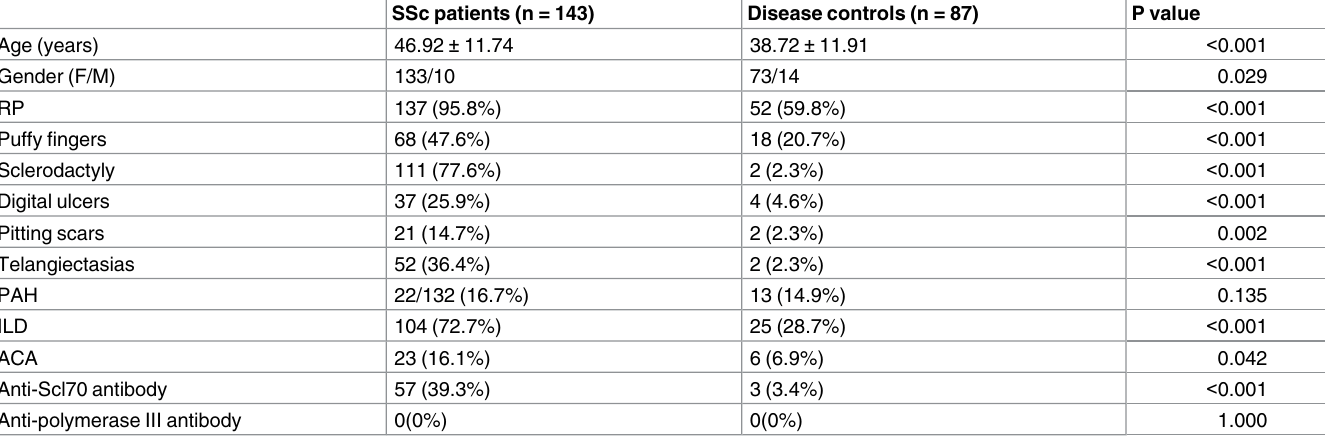
Table 2. The demagraphic and clinical features of SSc patients and disease